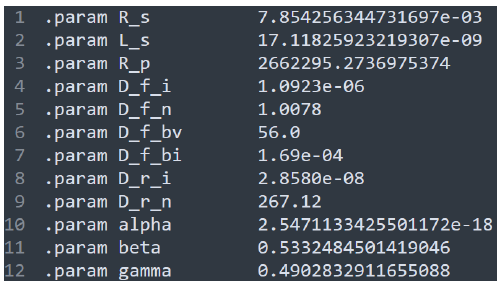
Figure 13. The text file containing the parameters expected by the LTspice full circuital model. Parameters for the 10SQ045 diode are